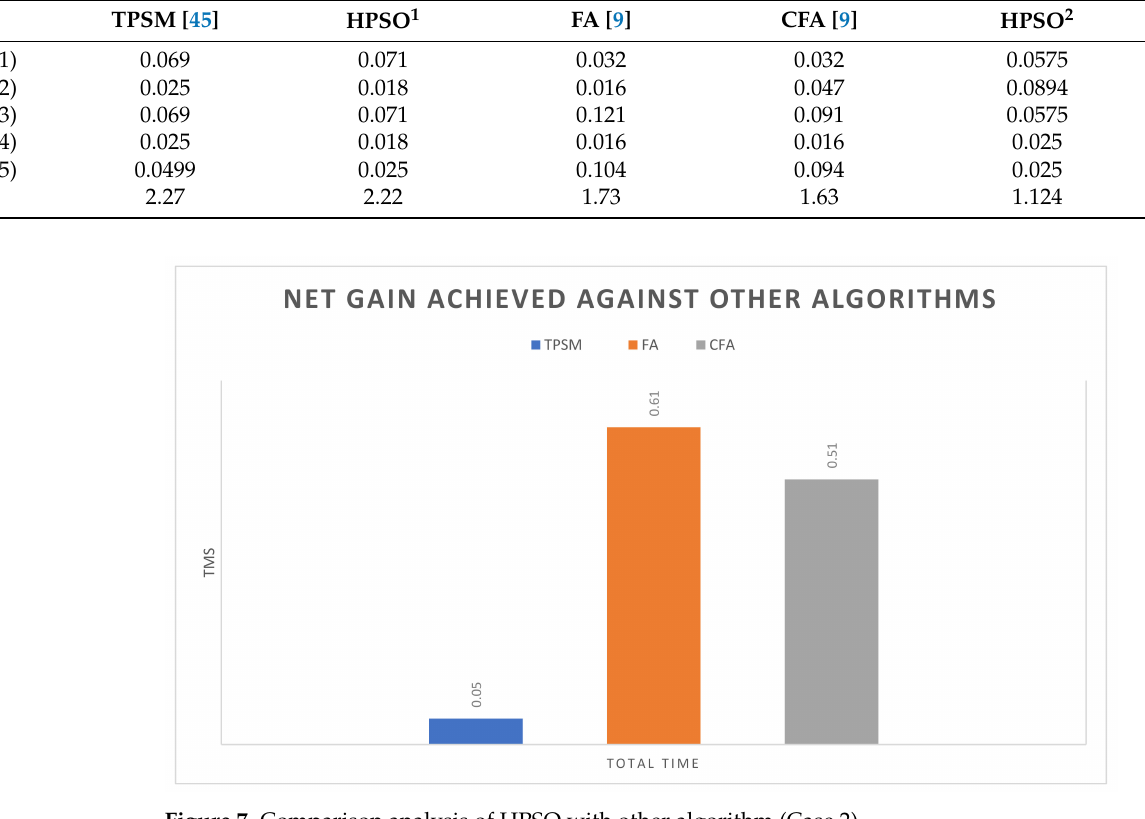
Table 5. Comparison of the optimized TMS with other techniques (case 2).